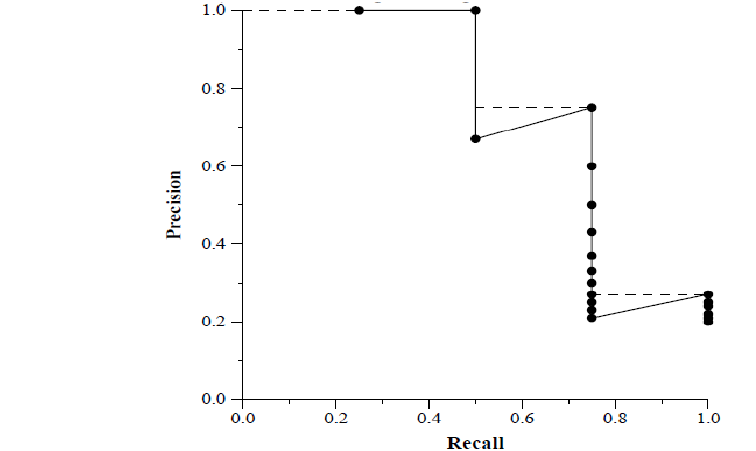
Figure 13 . Interpolation of precision and recall threshold